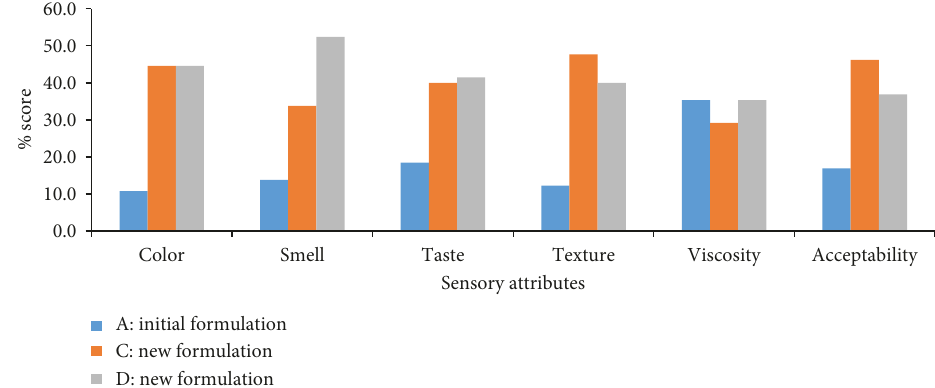
Figure 1: Preference ranking (%) of Kiptaruswo’s children porridge against different sensory attributes.